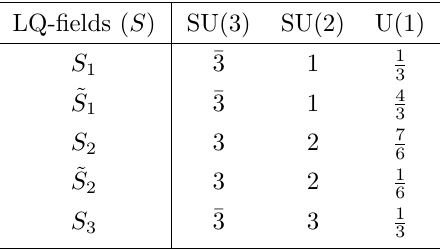
Table 1 . All possible representations of leptoquark fields under the SM gauge